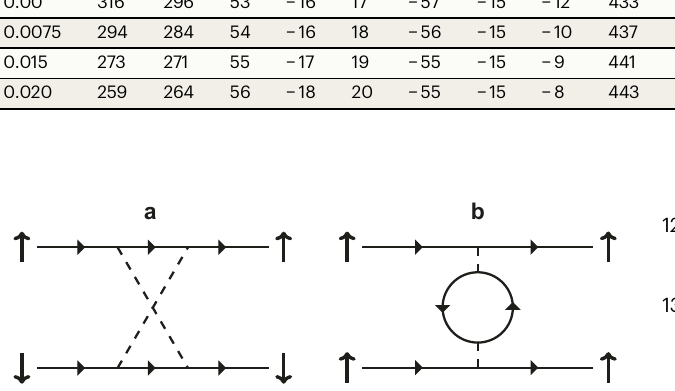
Fig. 9 | Two-particle interaction vertex diagrams. Second-order diagrams taken into account in Γ in a the even-parity channel, and b the odd-parity channel. The vertical arrows denote pseudo-spin, and the dashed lines contain all the terms of Eq.(8).Theapproachisasymptomaticallyexactintheweak-couplinglimit, U / t →